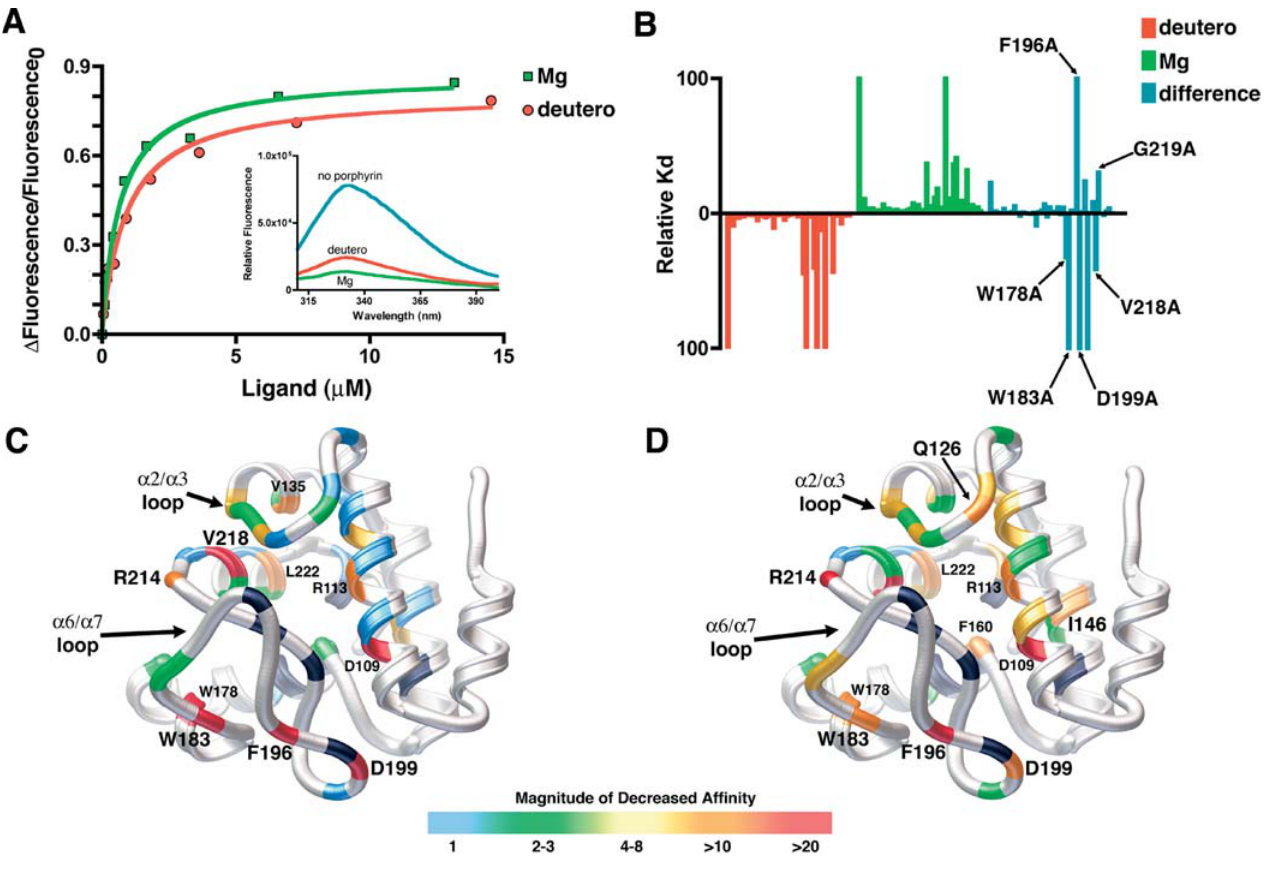
Figure 5. Quantitative Analysis of Porphyrin Binding by SynGUN4 (A) Comparison of the binding of SynGUN4 to analogs of both Proto and Mg-Proto. Both Mg-Deutero and Deutero quench endogenous tryptophan fluorescence upon binding (inset). A single binding site was assumed for the fitted line. (B) Relative dissociation constants were determined for each mutant and compared to the wild-type dissociation constant for both Deutero (red bars) and Mg-Deutero (green bars). The difference between these two sets of constants was calculated (blue bars). (C) Rendered ribbon diagram of the GUN4 core domain with the relative dissociation constants of each mutant for Deutero mapped onto the structure. While in some cases several different amino acid replacements were tested at particular positions, only the results obtained for the alanine mutations are mapped on the backbone structure shown. The x-fold change in the magnitude of the affinity of Deutero for each mutant is color-coded, as depicted by the scale shown at the bottom. Most amino acid changes did not alter binding affinity, as shown by the preponderance of light blue. Of the mutations that measurably alter binding affinity, the majority reside on the ‘‘ greasy palm ’’ of the GUN4 core domain. Several other energetic hotspots reside on the a 2/ a 3 and a 6/ a 7 loops. Positions of mutations that exhibit a greater than 10-fold decrease in affinity are labeled. Positions colored black failed to produce properly folded protein when mutated to alanine and expressed in E. coli . (D) Rendered ribbon diagram of the GUN4 core domain with the relative dissociation constants of each mutant for Mg-Deutero mapped onto the structure. Color coding is the same as for (C). In contrast to Deutero binding, many more mutants alter in vitro binding as shown by the lesser amount of light blue and the prominence of green and yellow color coding. DOI: